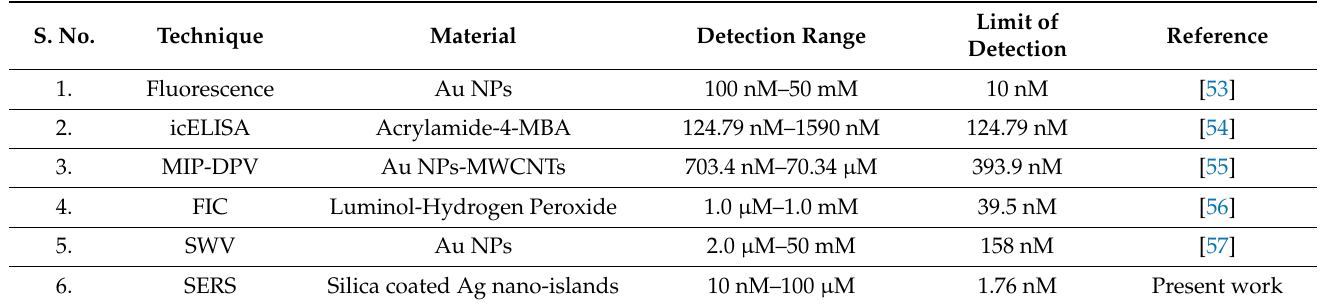
Table 1. Comparison of the present work with other reported works in which SERS platforms were fabricated using different